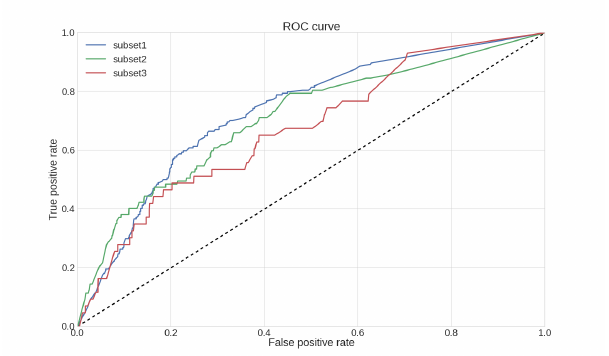
Figure 8: Receiver Operating Characteristic Curve(segmentation threshold=0.15) using Gradient